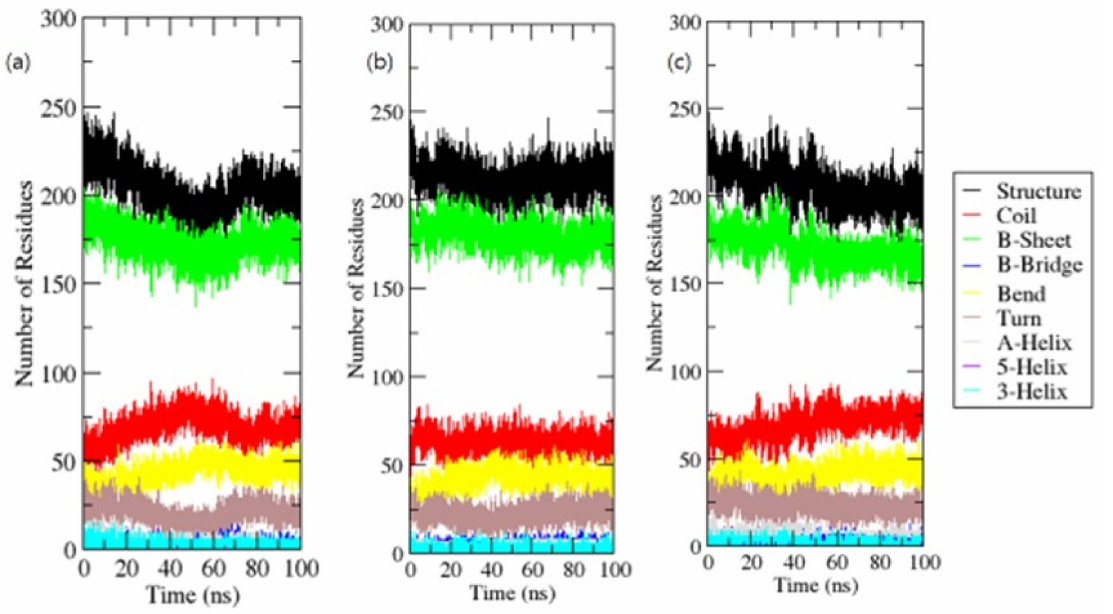
Figure 9. Secondary structure elements.